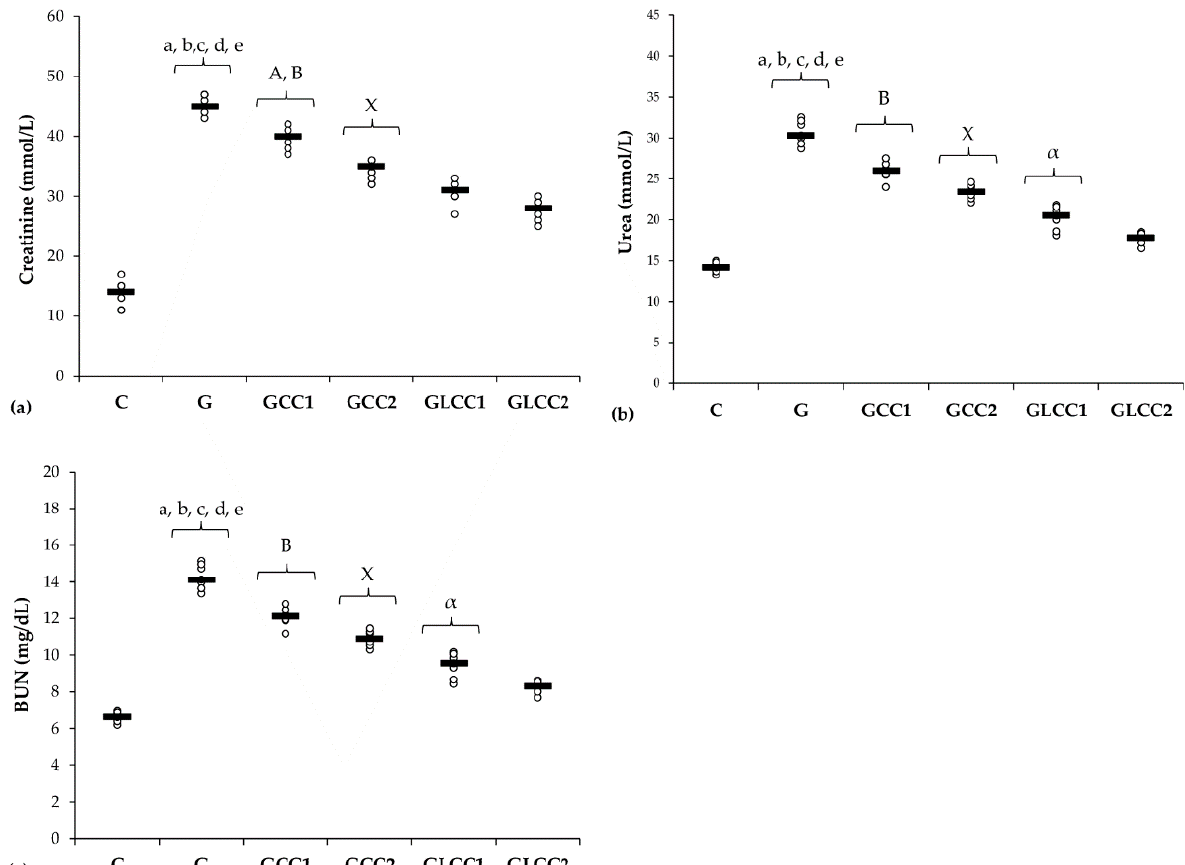
Figure 5. Variation by groups of serum levels of renal function parameters: ( a ) Creatinine, ( b ) Urea, ( c ) (BUN) blood urea nitrogen by groups. Notes: The circles represent the individual values, and the horizontal line is given by the median. Abbreviations: C, Control; G, Gentamicin; GCC1, Gentamicin and CC1 solution; GCC2, Gentamicin and CC2 solution; GLCC1, Gentamicin and LCC1 solution; GLCC2, Gentamicin and LCC2 solution; The letter codes correspond to the p -values < 0.006: a G compared to C; b G compared to GCC1; c G compared to GCC2; d G compared to GLCC1; e G compared to GLCC2; A GCC1 compared to GCC2; B GCC1 compared to GLCC1; X GCC2 compared to GLCC2; α GLCC1 compared to GLCC2.